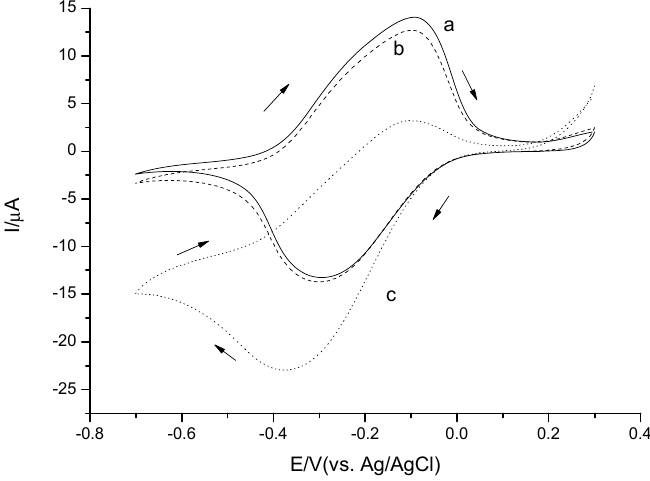
O (b) and 1 mM H O (c). Scan rate 20 mV·s − 1 2 2 2 2